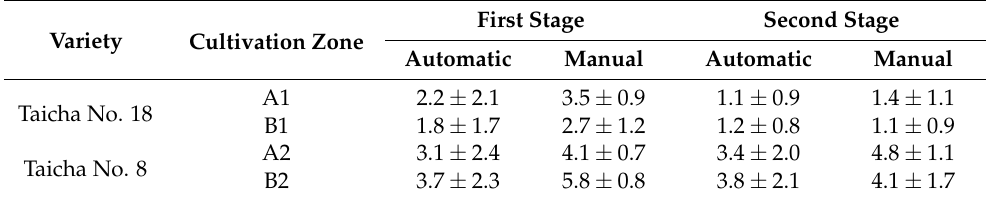
Table 4. Comparison of the results of estimating the number of diseased leaves using automatic and manual measurement.